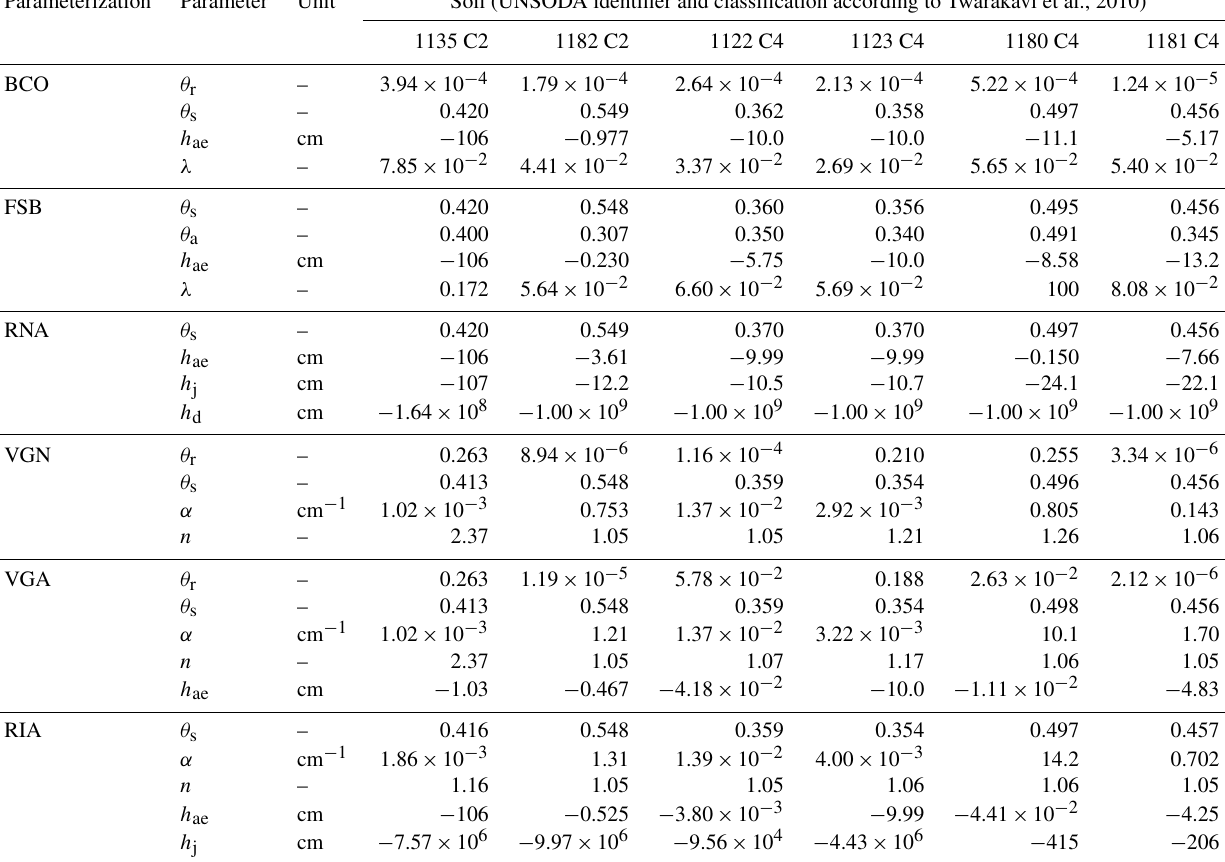
Table C4. The fitting parameters and their values for six parameterizations for clayey soils from the UNSODA database (National Agricul- tural Library, 2015; Nemes et al., 2001). The three-character parameterization label is explained in the main text. Parameterization